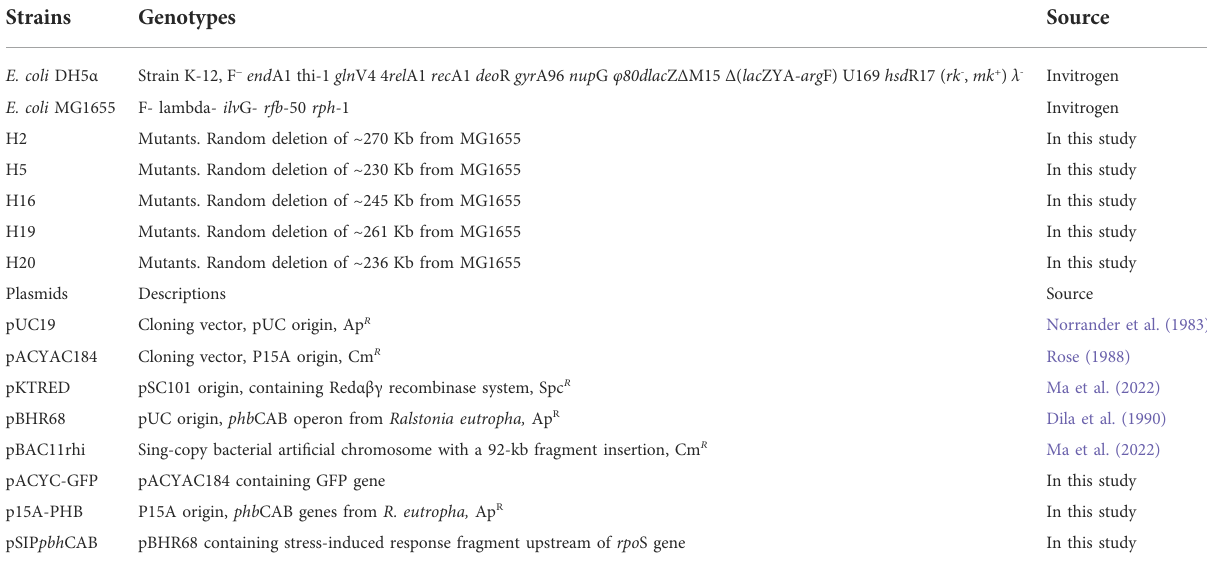
L vitamin B1. M9-glucose media: M9 basal medium supplemented with appropriate glucose. When appropriate, ampicillin (Ap, 100 mg/L), chloramphenicol (Cm, 25